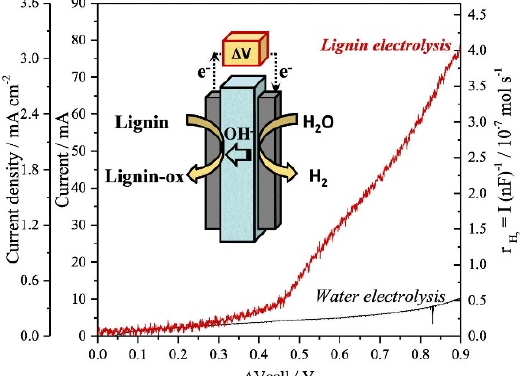
Figure 3. Schematic illustration of lignin electrolysis in polymer electrolyte membrane (PEM) elec- trolyzer in a continuous ‐ flow system at 80 °C together with linear sweep voltammetry (0–0.9 V; sweep rate: 0.5 mV/s), anode: 10 g/L lignin (1 M NaOH), flow rate: 2.5 mL/min; cathode: NaOH (1 M), flow rate: 2.5 mL/min. Reprinted with permission from Ref. [83]. Copyright (2019) Elsevier.